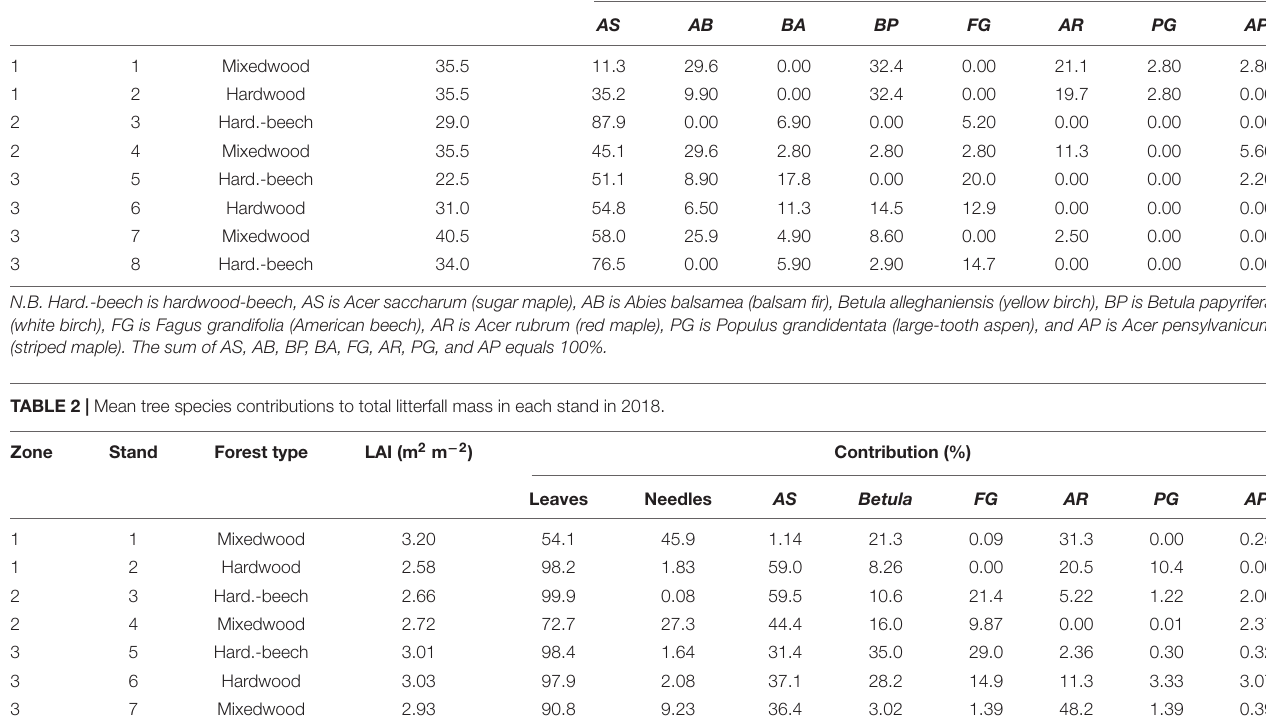
TABLE 1 | Total basal area and tree species contributions to total basal area in each stand in 2018. Zone Stand